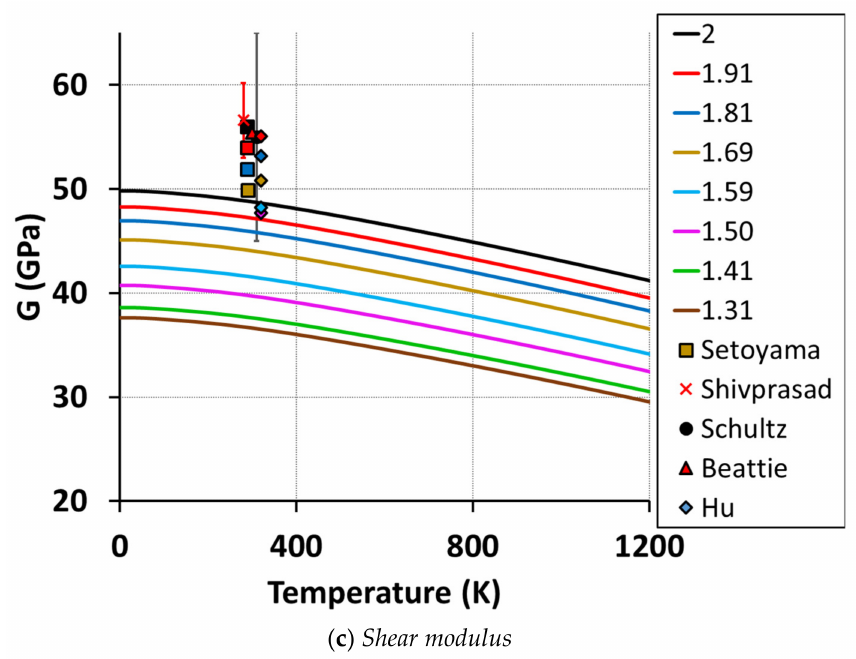
Figure 7. DFT-QHA-calculated elastic moduli (Bulk modulus ( a ), Young’s modulus ( b ), and Shear modulus ( c )) as a function of temperature for various H / Y . Color of solid lines in legend shows H / Y . The DFT-QHA-derived properties are compared at room temperature with available experimental data. Literature taken from Funston et al. (dashed pink line for YH 1.5 ) [10], Setoyama et al. (varying colored boxes for 1.7 ≥ H / Y ≥ 2) [8], Shivprasad et al. (red cross for YH 1.90 ) [17], Schultz et al. (black circles for YH 2 ) [13], Beattie et al. (red triangles for YH 1.93 ) [11], and Hu et al. (varying colored diamonds for 1.52 ≥ H / Y ≥ 2 ) . Literature data near room temperature, shifted by a few degrees for better